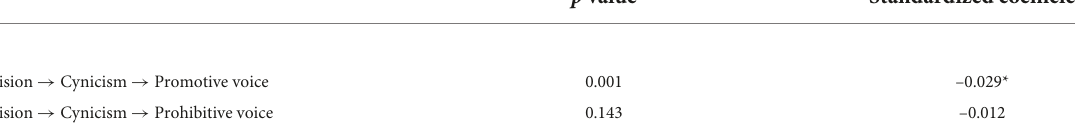
TABLE 4 Results of mediation